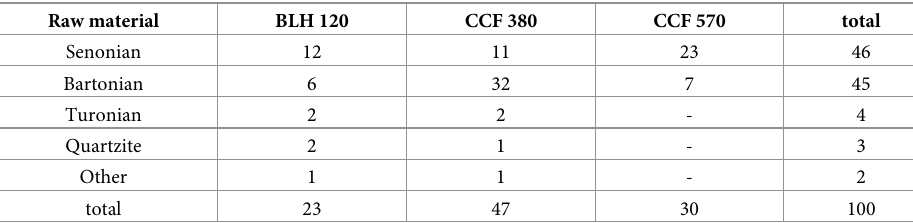
Table 2. The raw materials of the selected blades. Raw